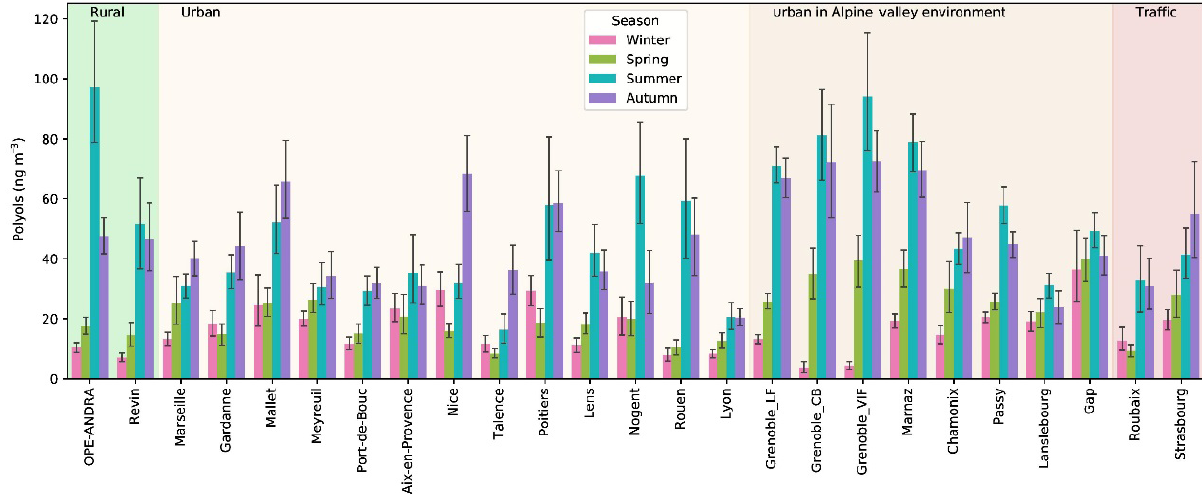
Figure 6. Spatial and seasonal distributions of atmospheric polyol average concentrations (ngm − 3 ) for various types of sites in France. Error bars correspond to standard deviations calculated with seasonal concentrations. Years of PM sampling campaigns are not concurrent at all sites (see Fig. S1). The seasons were defined as follows: Winter is December to February, Spring is March to May, Summer is June to August, and Autumn is September to